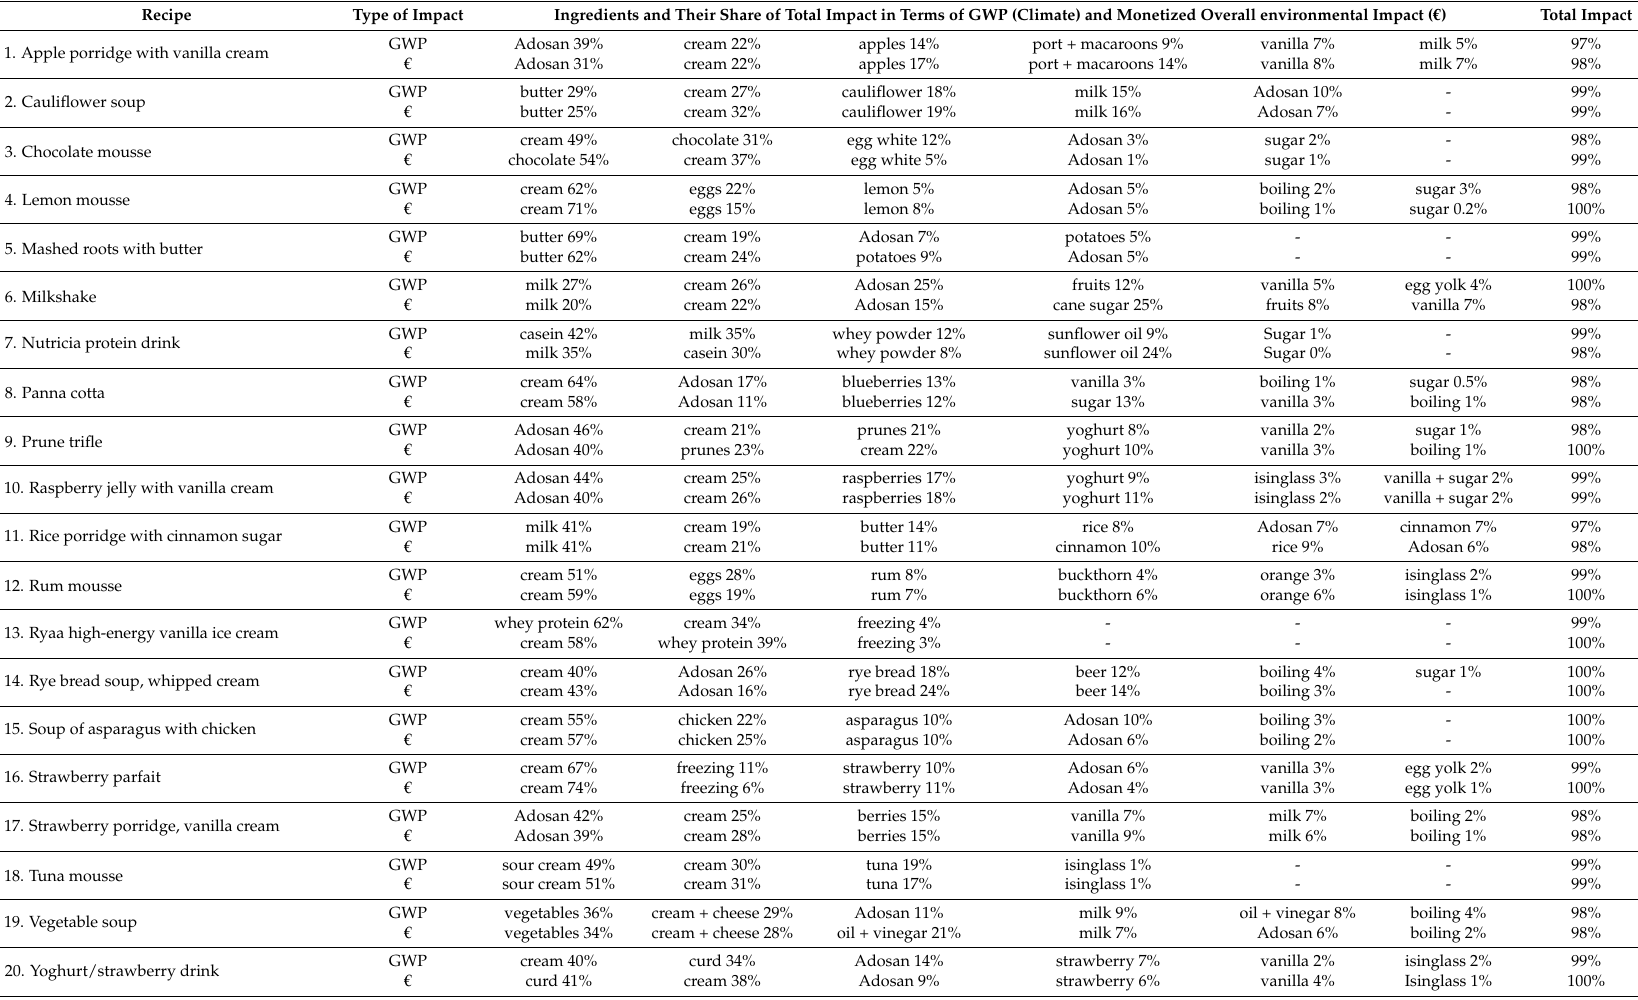
Table 1. Ingredients of the 20 snack meal recipes and their relative share of total impact in terms of GWP (climate) and monetized overall environmental impact ( € ). 97–100% of the total impact is accounted for by 3–6 ingredients and processes. Adosan stands for one of several types of Adosan ® protein